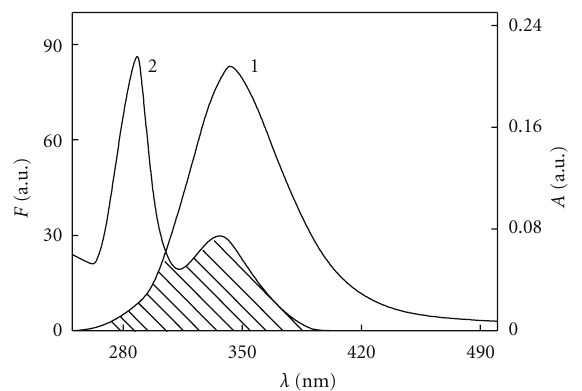
Figure 6: Fluorescence emission spectra for BSA(1) and UV absorbance spectra for Avelox (2). C Avelox = C BSA = 6.0 × 10 − 6 M; T = 293 K.